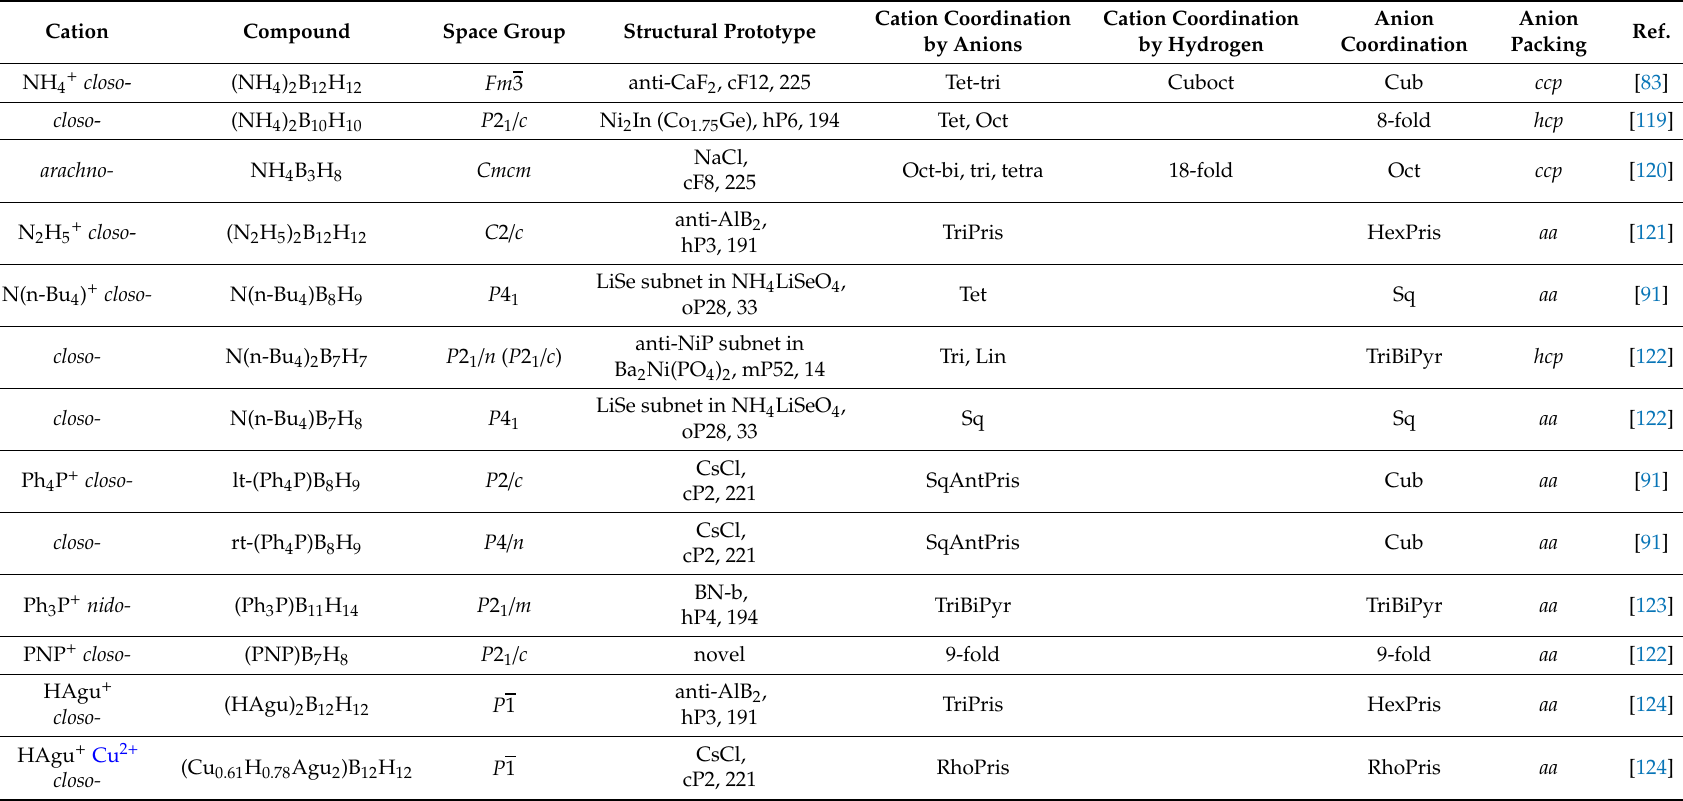
Color coding: transition elements: